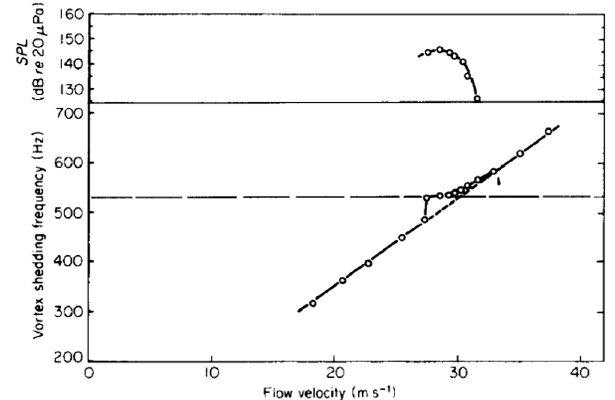
Figure 12. Variation laws of sound pressure frequency and sound pressure level with inlet flow velocity in the literature [15].